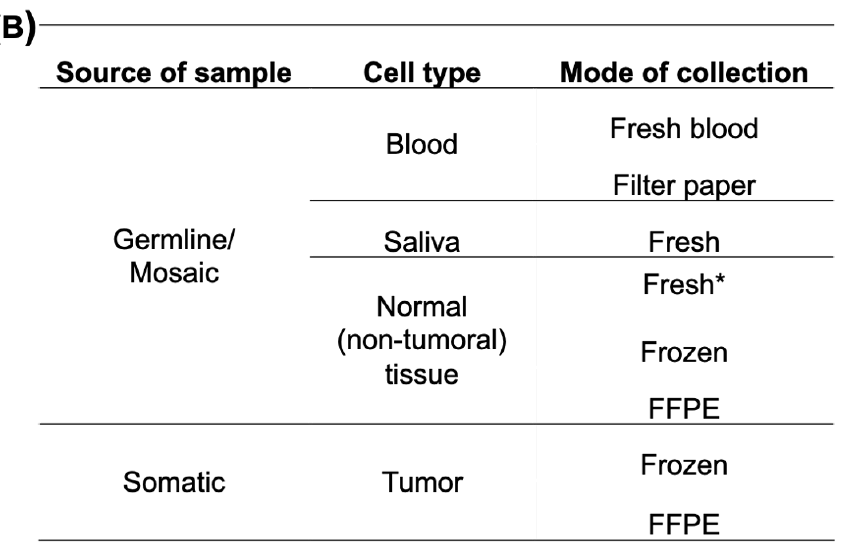
Figure 3. ( A ) A proposed workflow to identify driver mutations in pheochromocytoma and/or paragangliomas (PPGLs). The process is modified based on the type of sample available for analysis and initial clinical information. The ultimate goal is to establish a germline or somatic genetic diagnosis. In some cases, extensive experimentation may be necessary, as shown by directional lines. A definitive, unambiguous diagnosis may not be achieved in all cases (dashed line), and additional research is required. Limitations may include samples with only germline material available, without family history/or samples from informative relatives, and no clear candidate variant. * areas with lower coverage are supplemented by Sanger sequencing; NGS = next-generation sequencing; WES = whole exome sequencing; WGS = whole genome sequencing ( B ) Materials used for analysis; FFPE = for- malin-fixed, paraffin-embedded; * cell culture compatible media.